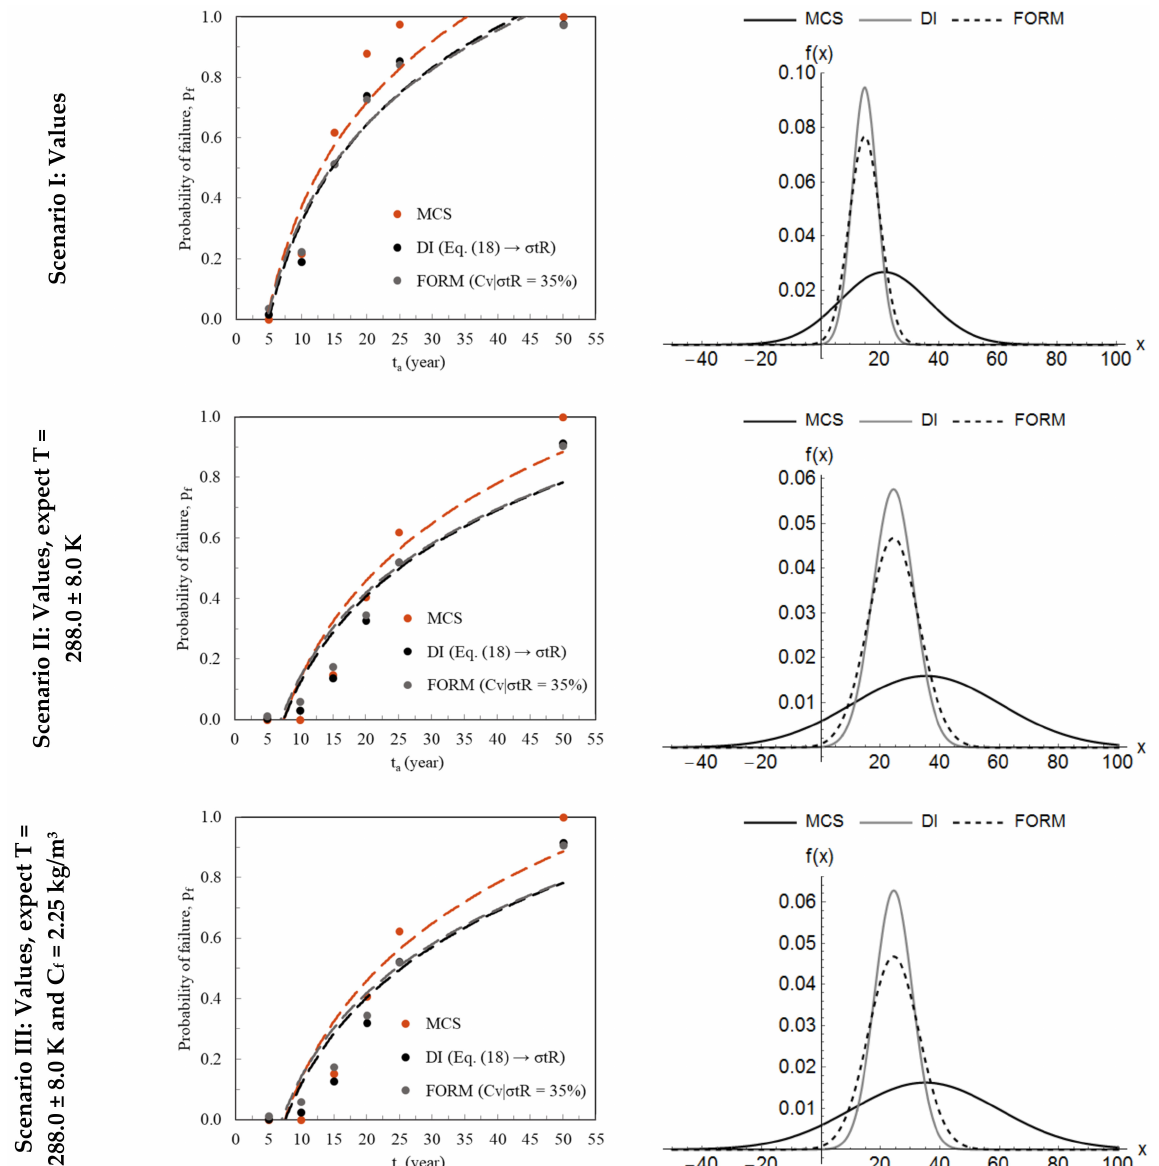
Figure 4. Results of scenarios I, II, and III. Probability of failure (or CDF) vs. t a ( left ), and PDFs by three methods ( right ) (MCS samples with k =